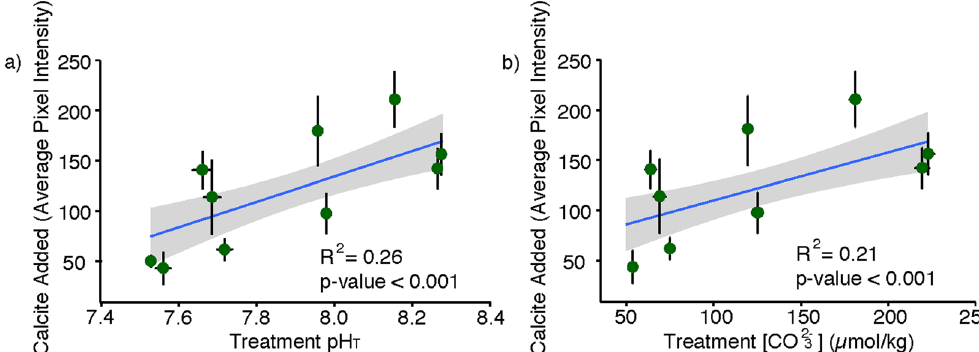
Figure 1. Mean calcification in Globigerina bulloides as measured by calcein uptake (average pixel intensity), with respect to ( a ) pH and ( b ) [CO 32 − ]. Error bars show standard deviation in both the x and y directions. These data are fit with a linear model with a 95% confidence envelope. The R 2 and p-value refer to the fit of individual foraminifera to this curve (data for individual foraminifera can be found in Supplementary